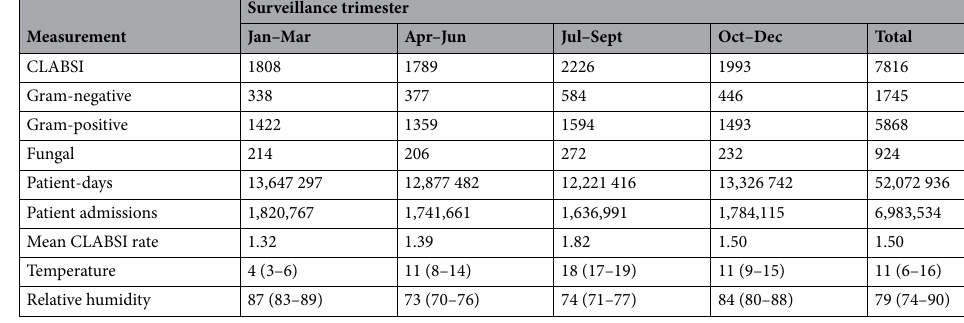
Table 1. Central line-associated bloodstream infections and microorganism incidence per trimester among 104 participating hospital sites. Quarterly data on hospital-wide mean CLABSI rates per 10 000 patient-days. The rate of total CLABSI classifies polymicrobial BSI as a single CLABSI. CLABSI central line-associated bloodstream infection.